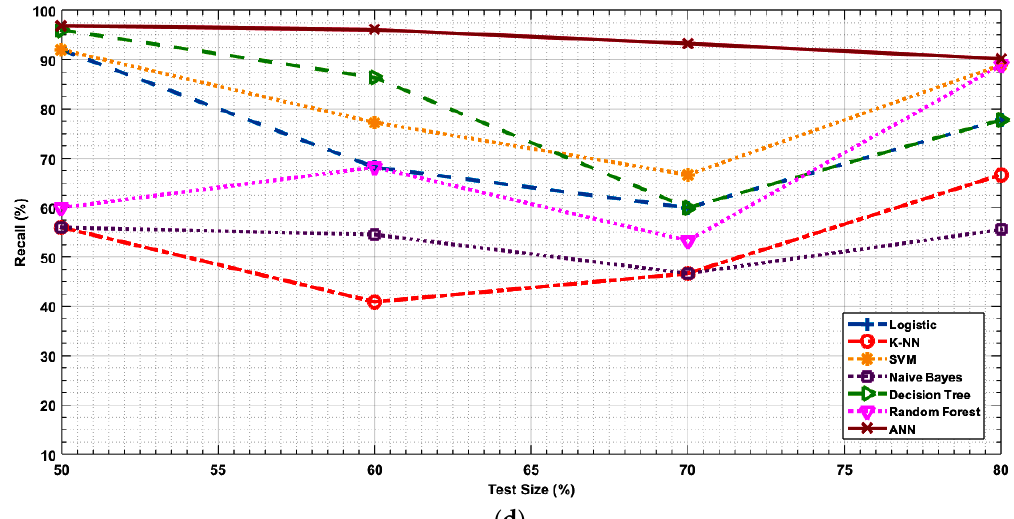
Figure 3. ( a ). Accuracy vs. size of the training set as a percentage of the total input data set used for training. ( b ). F 1 score vs. size of the training set as a percentage of the total input data set used for training. ( c ). Precision vs. size of the training set as a percentage of the total input data set used for training. ( d ). Recall vs. size of the training set as a percentage of the total input data set used for training.